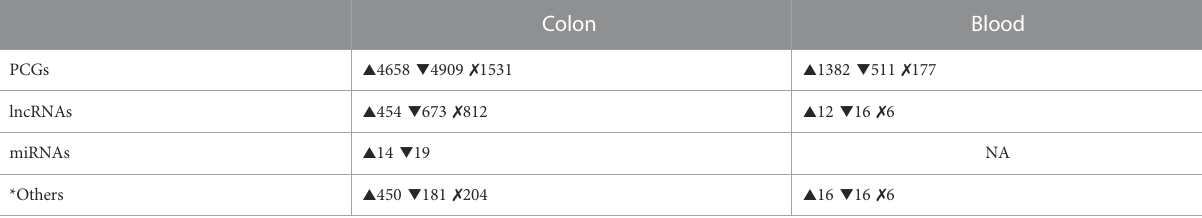
TABLE 3 Numbers of SDE genes in human colon and blood combined datasets. (For all padj ≤ 0.05 in min 2 datasets).